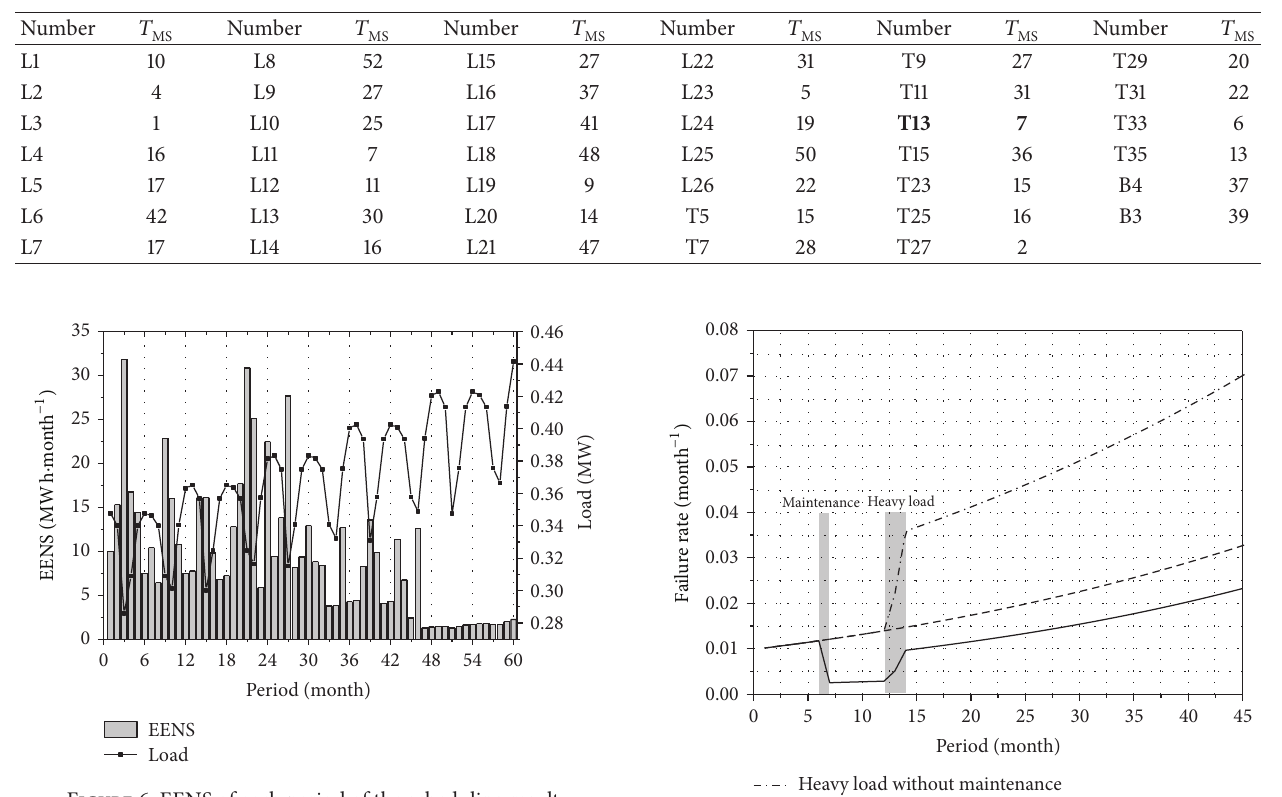
Figure 6: EENS of each period of the scheduling result.